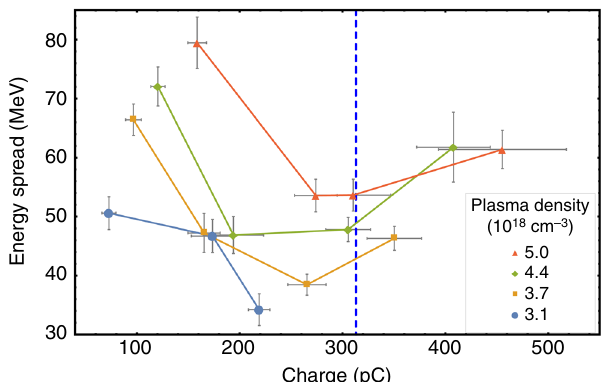
Fig. 3 Beam absolute energy spread dependency on charge. Shown is the FWHM energy spread. The dashed vertical line represents the optimal load expected from Eq. (1). The error bars represent the s.e.m. A graph showing the relative energy spread can be found in Supplementary